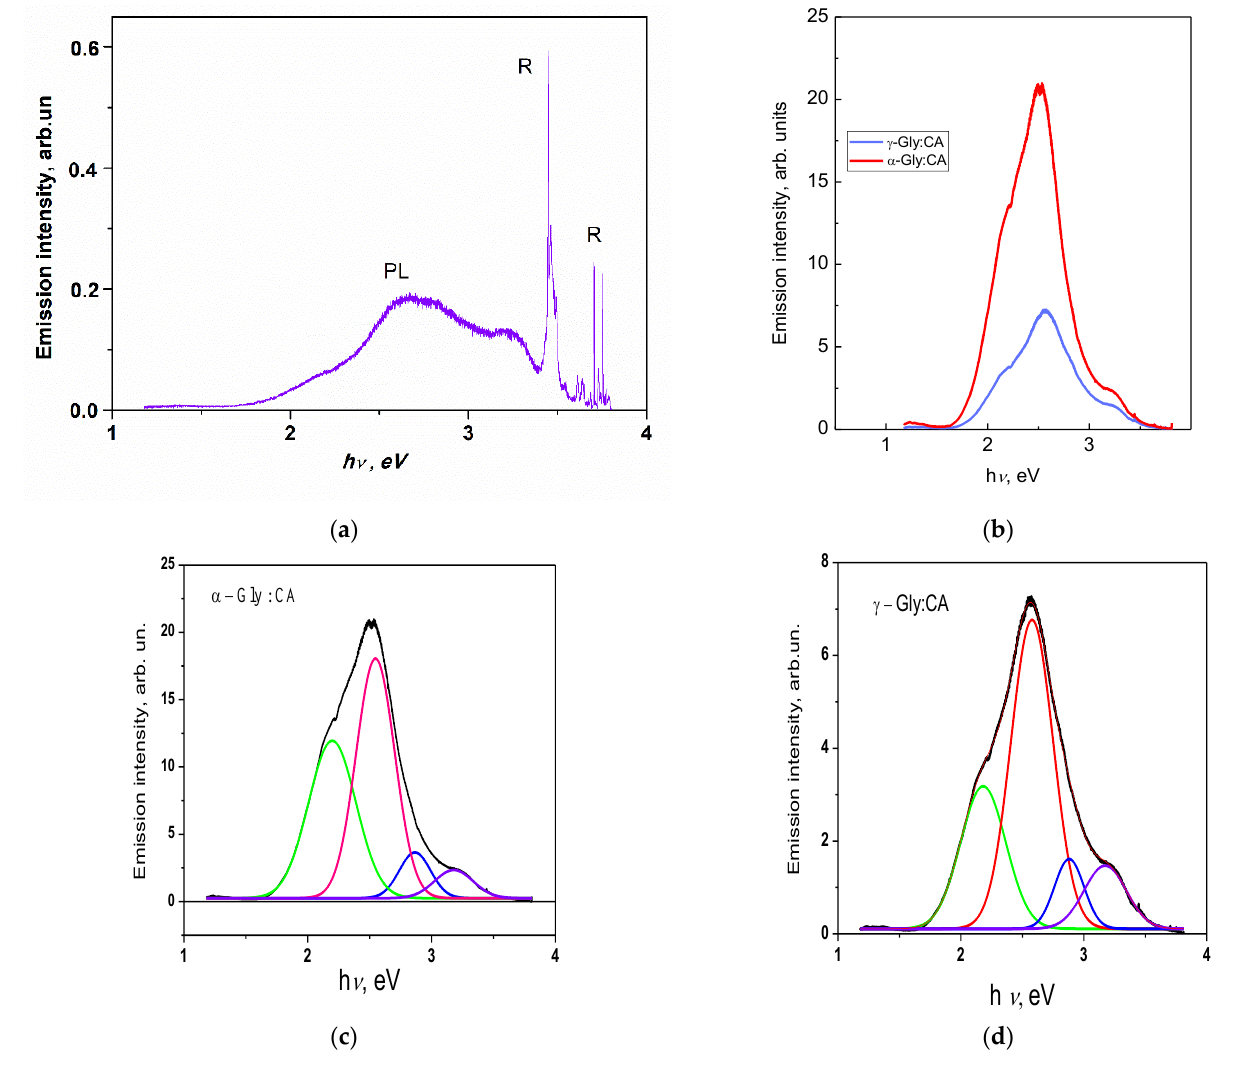
Figure 8. ( a ) Emission spectrum of “ pure ” γ -glycine wih a small admixture of citric acid. Here, R labels the Raman lines. ( b ) Emission spectra of γ - and α -glycine crystals doped with croconic acid. ( c ) Decomposition of the α -Gly:CA emission band profile into four Gaussian components. h ν exc = 3.8 eV. T = 300 K. ( d ) Decomposition of the γ -Gly:CA emission band profile into four Gaussian components. The Gaussian components in ( c , d ) are shown by different colors. Table 11. Resonance photon energies E ph , eV, normalized intensity Ai / A 2 obtained after decomposi- tion of PL spectra in α -Gly:CA, γ -Gly:CA and TGS:CA in four Gauss components. α -Gly:CA γ